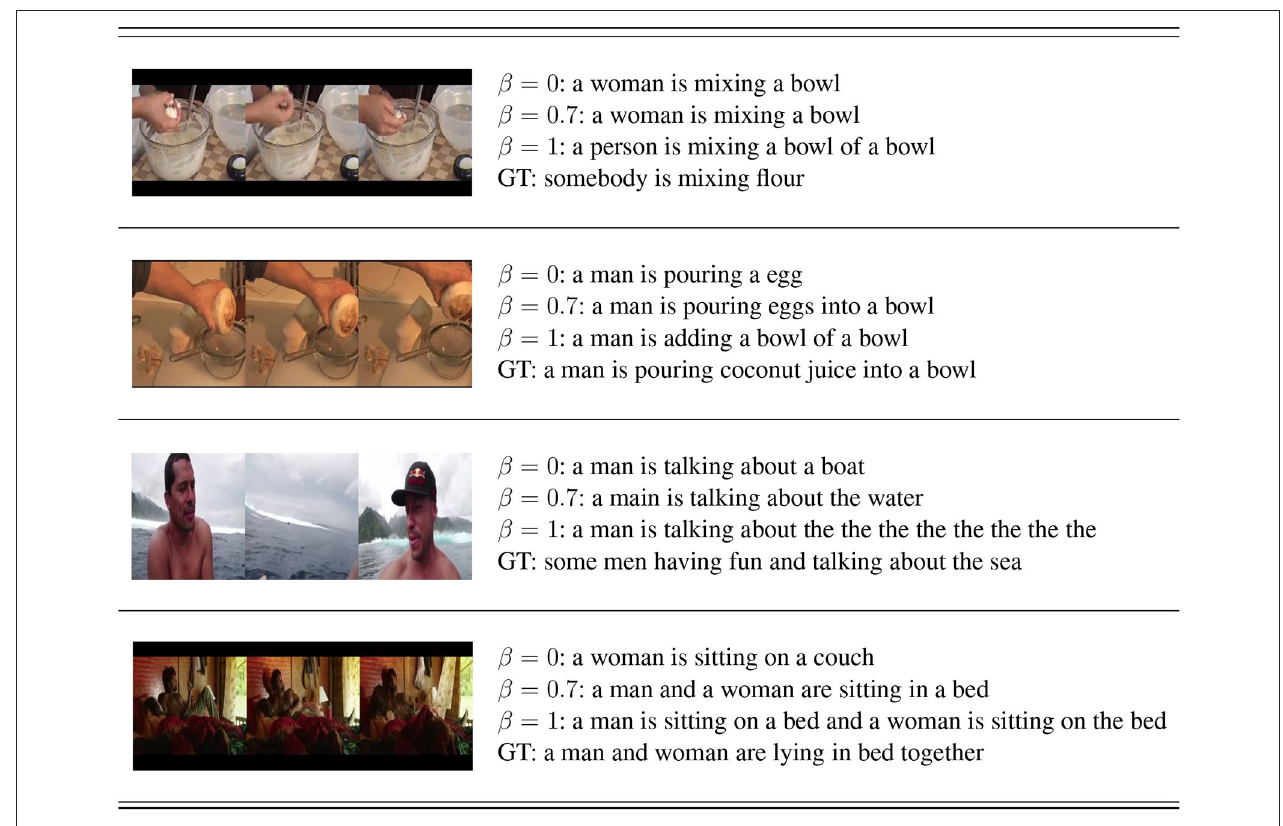
FIGURE 5 | Examples of machine-generated captions and human annotations